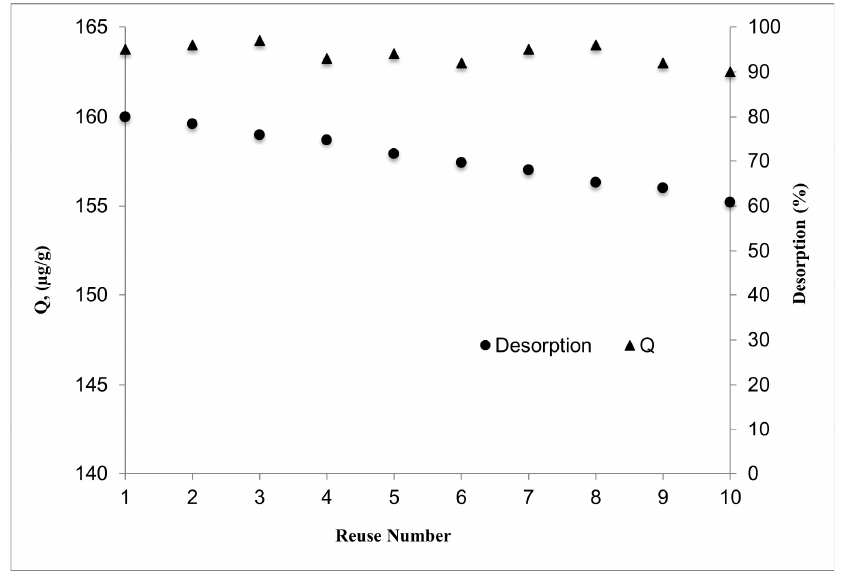
Figure 8. The reusability of E2-NP/BC-NFs: ( 𝑐 (cid:2868) : 1.0 mg/mL, pH:7, I.S. 0, 𝑊 (cid:3043)(cid:3028)(cid:3045)(cid:3047)(cid:3036)(cid:3030)(cid:3039)(cid:3032)(cid:3046) : 100 mg, t: 25